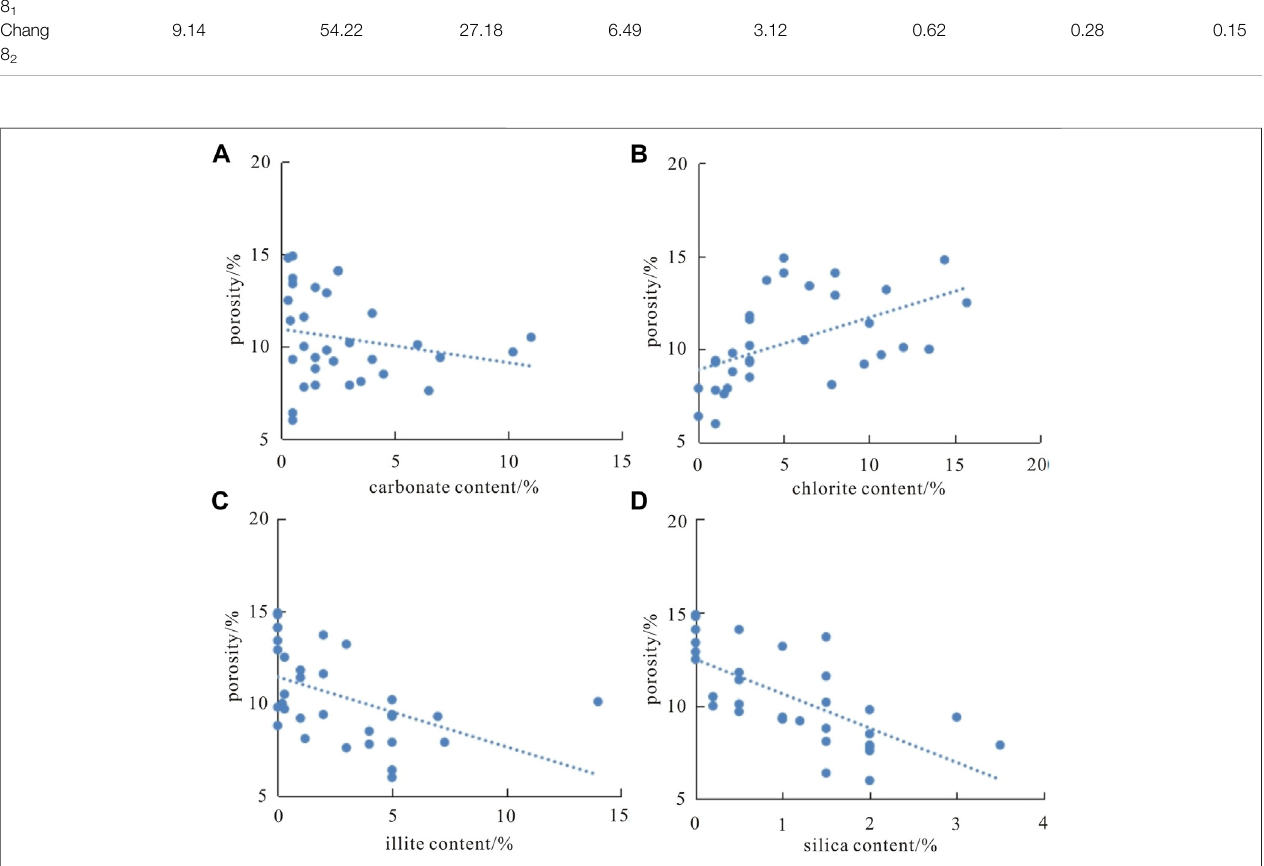
FIGURE7| Relationshipbetweenporosityandcarbonatecontent (A) ,chloritecontent (B) ,illiteconcent (C) ,silicacontent (D) ofChang8reservoirinWuqi-Zhijing- Ansai area.